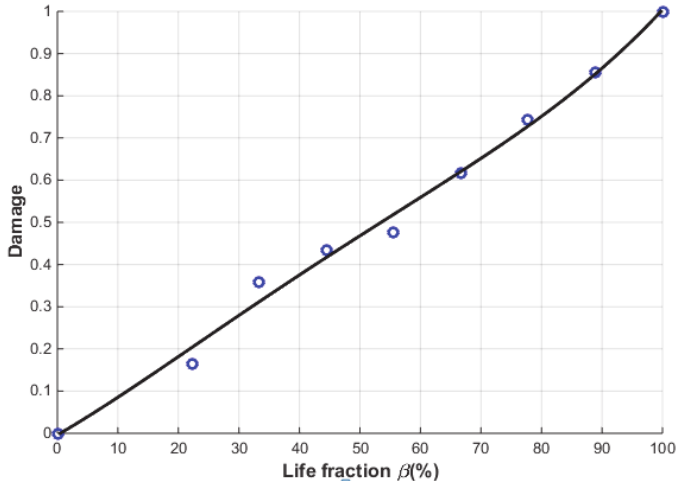
Figure 8: The static damage evolution based on the bursting pressures as a function of the fraction of